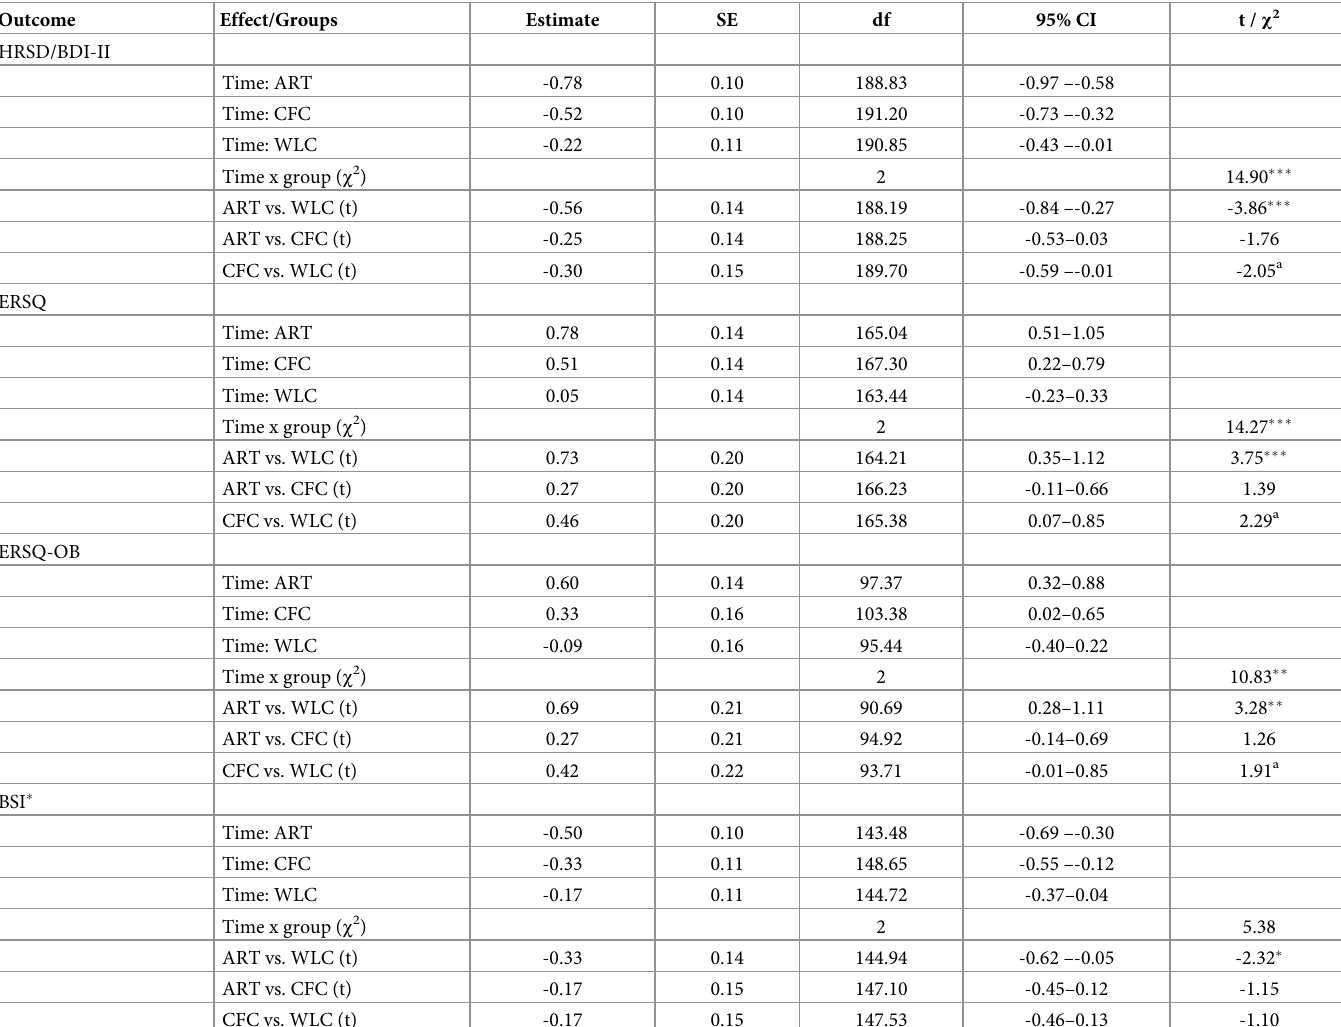
Table 3. Simple slopes, cross-level interaction effects and pairwise comparisons between groups for depression, comorbidity, and emotion regulation total scores.